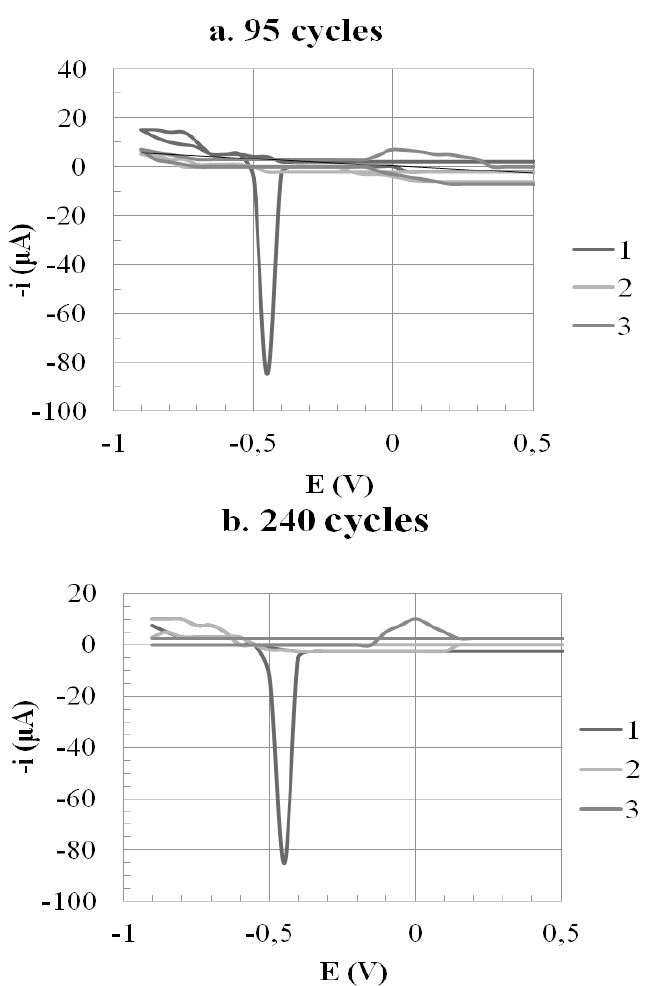
Figure 8. Cyclic voltammograms of (1) 1×10 -3 mol L -1 Pb 2+ +1 mol L -1 HClO (3) 1×10 -3 mol L -1 Pb 2+ +1 mol L -1 HClO